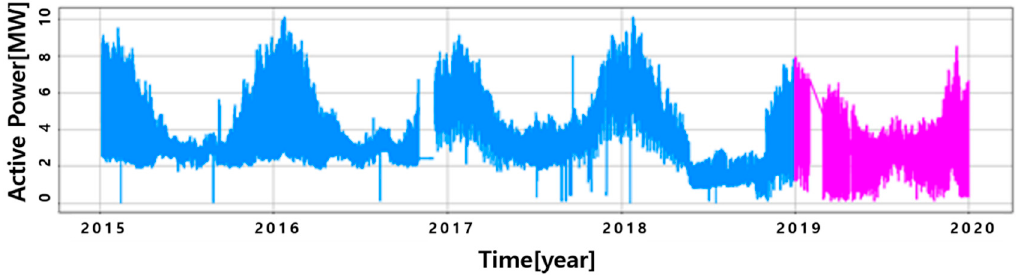
/ L (blue: measured, red: predicted) .